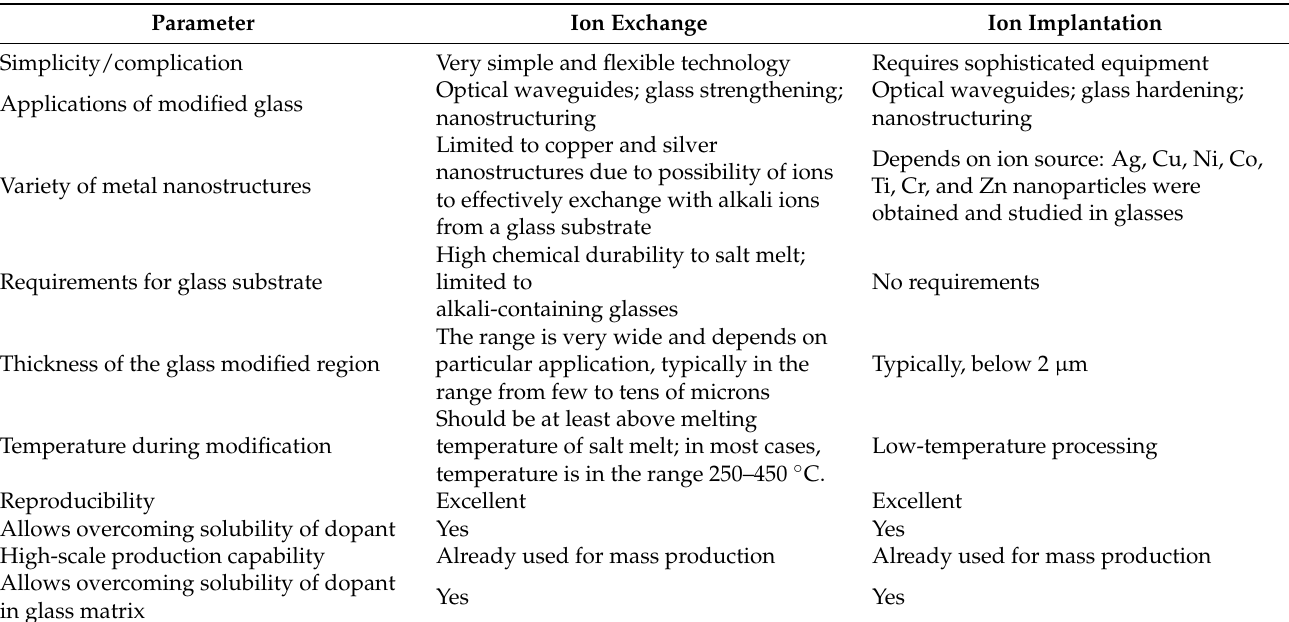
Table 1. Comparison of the ion implantation and ion exchange